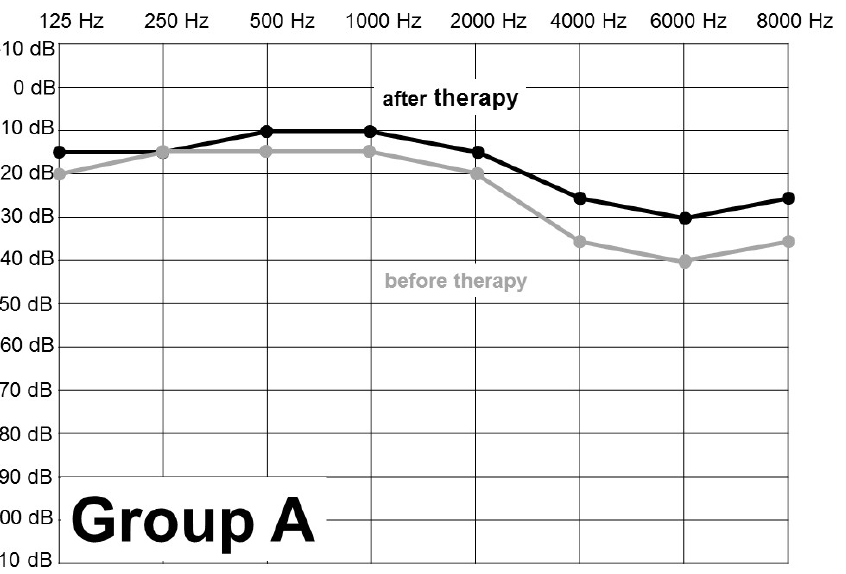
Figure 1. PTA before and after the treatment of AAT—Group A—soldiers (n = Figure 1 . PTA before and after the treatment of AAT- Group A - soldiers (n = 83).